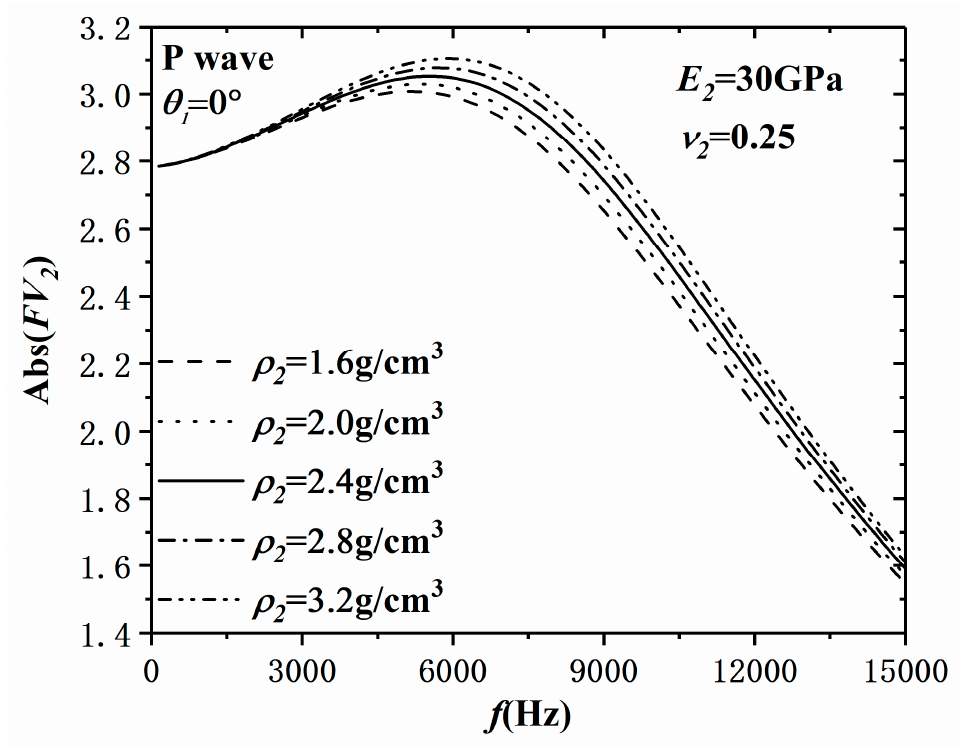
Figure 5. Influence of the expansive grout density on theoretical amplitude spectrum of gauge combination FV 2 for the incident P wave. 185 Table 4. Influence of the expansive grout density on theoretical amplitude spectrum of gauge 186 combinations FV 2 , FV 4 , FS, TV and TS for the incident P wave. 187